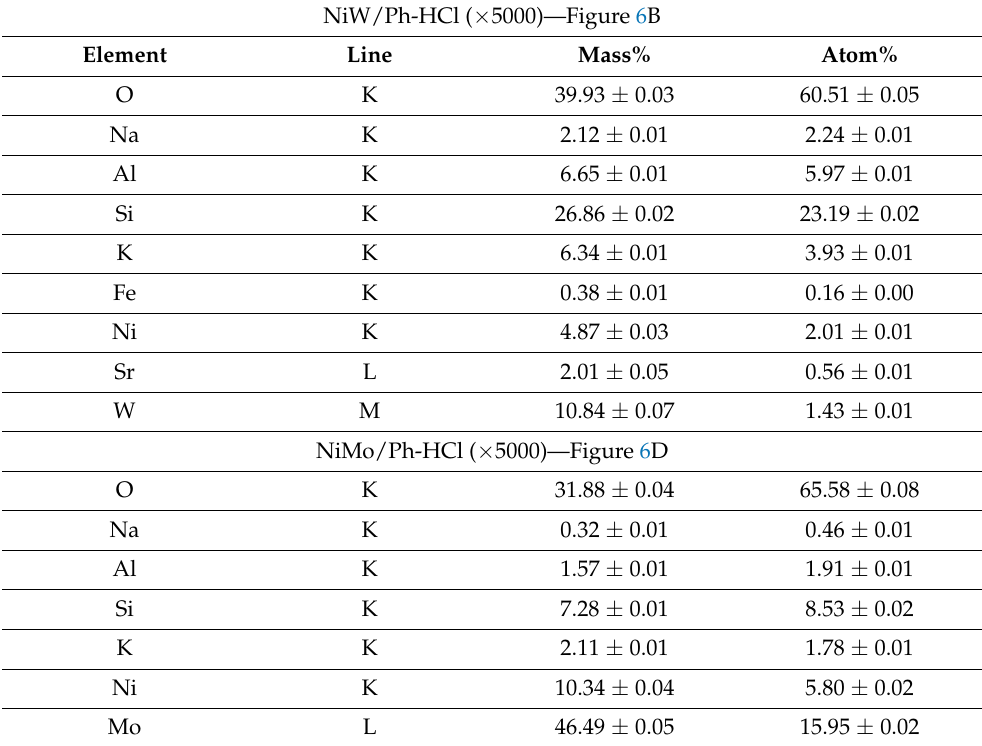
Table 3. EDS results. Element contents on the scanned surface (pictures at 5000 × shown in Figure